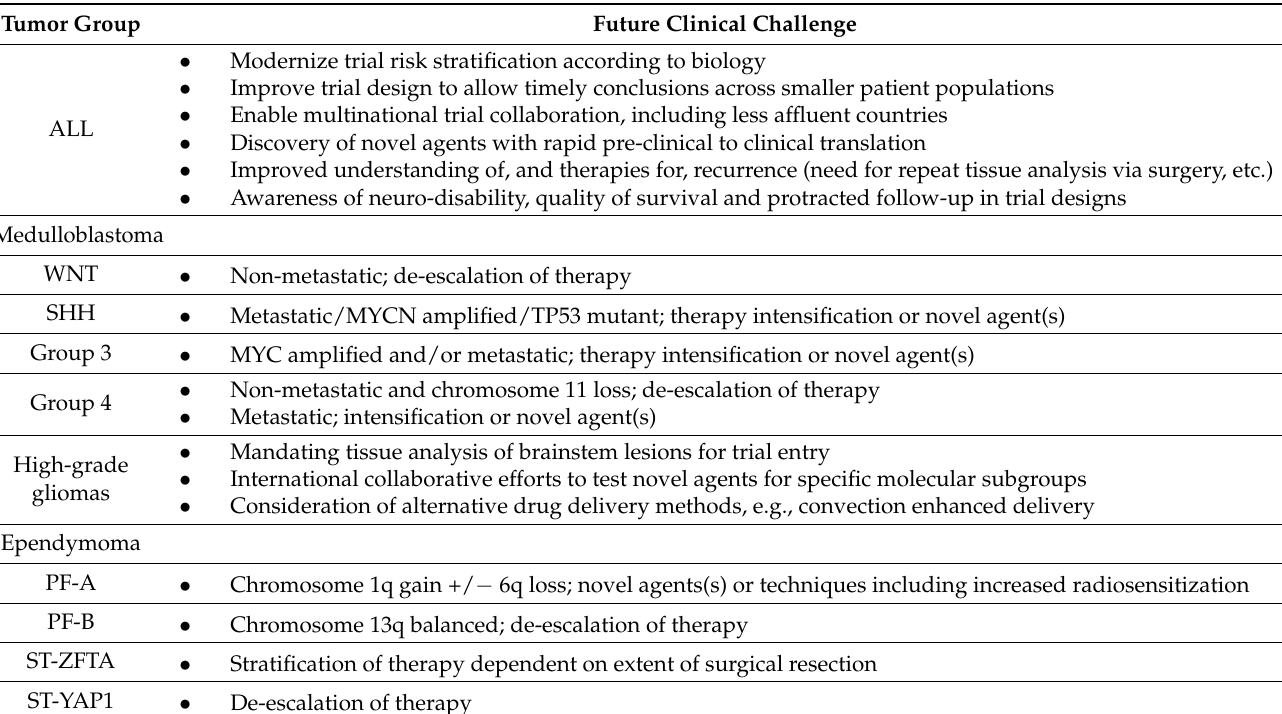
Table 2. Future clinical challenges for pediatric malignant brain